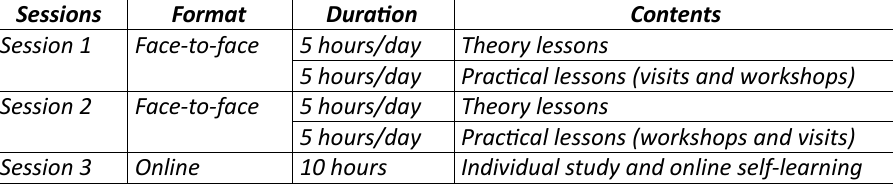
Table 1. Structure of an EXPLORE